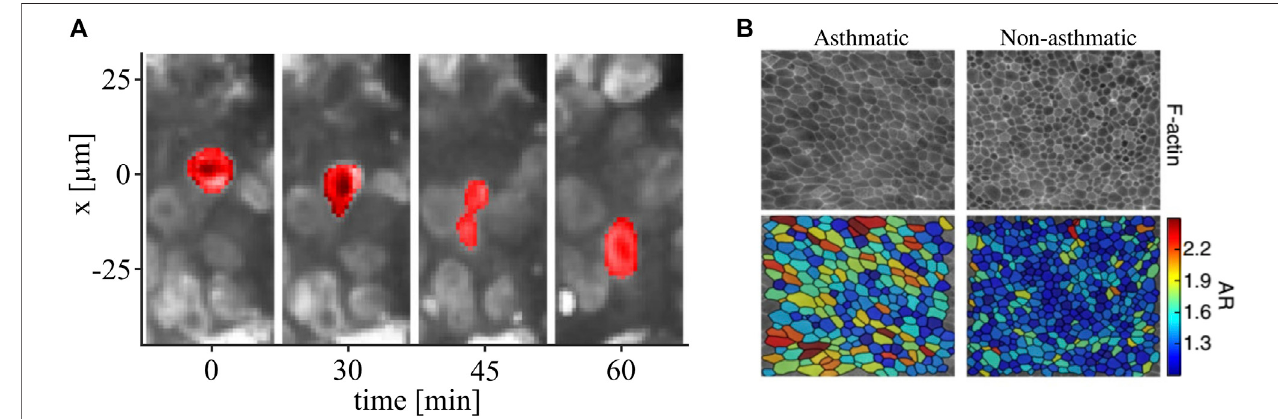
FIGURE 1 | Shape-dependent unjamming. (A) Time series of an MDA-MB-436 cancer cell nucleus (red) deforming itself to move through a densely packed three- dimensionalcellspheroid.NucleiarestainedwithSiR-DNA. From[4] (B) ,monolayersofcellsfromasthmaticdonorsweremoremotileandhadmoreelongatedcellsthan monolayers of cells from healthy donors. Images were taken and adopted from Atia et al. [28]. Copyright ID